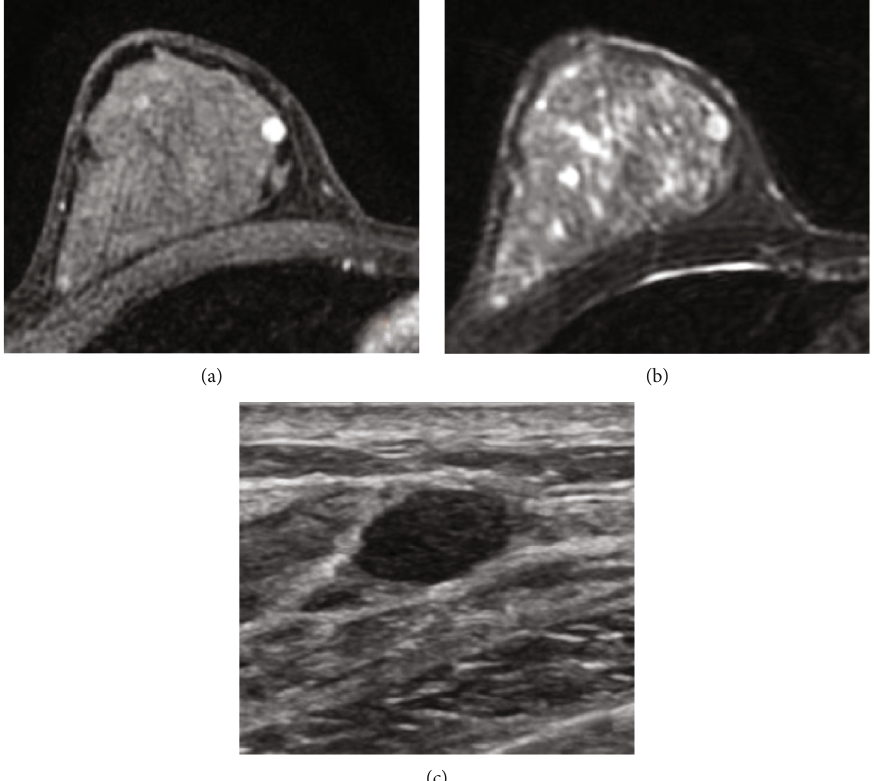
Figure 1: (a) MRI of the right breast with IV gadolinium shows an oval enhancing mass in the upper inner right breast middle depth; (b) T2-weighted images show bright signal, though less bright than cysts seen elsewhere in the breast. Slit-like spaces are not de fi nitely appreciated, possibly due to the small size of the fi nding. (c) Second-look ultrasound shows an oval, microlobulated, hypoechoic mass in the upper inner right breast, corresponding with that seen on